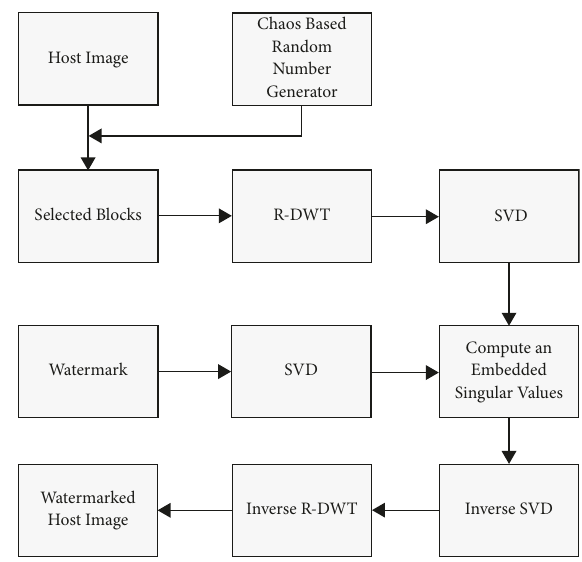
Figure 9: Proposed watermarking embedding